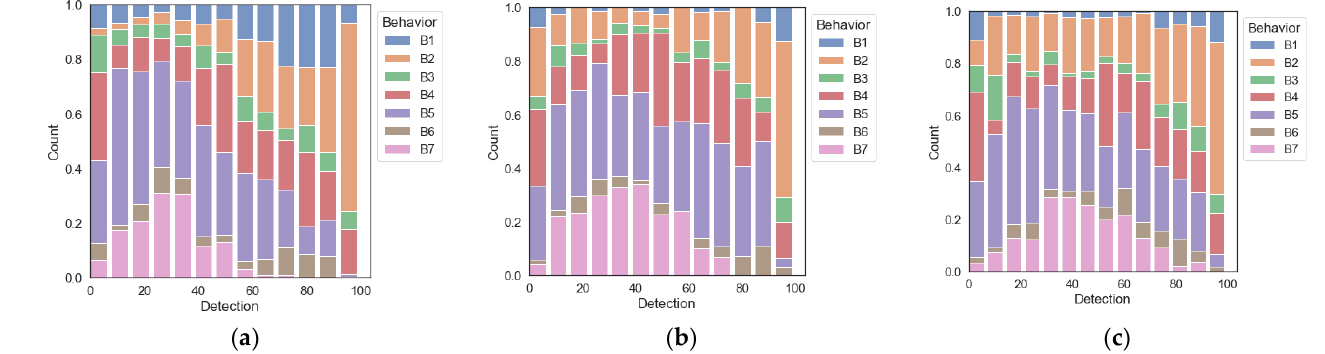
Figure 7. Distribution of detection by dog behavior per method: ( a ) FasterRCNN; ( b ) YOLOv3; ( c ) YOLOv4.